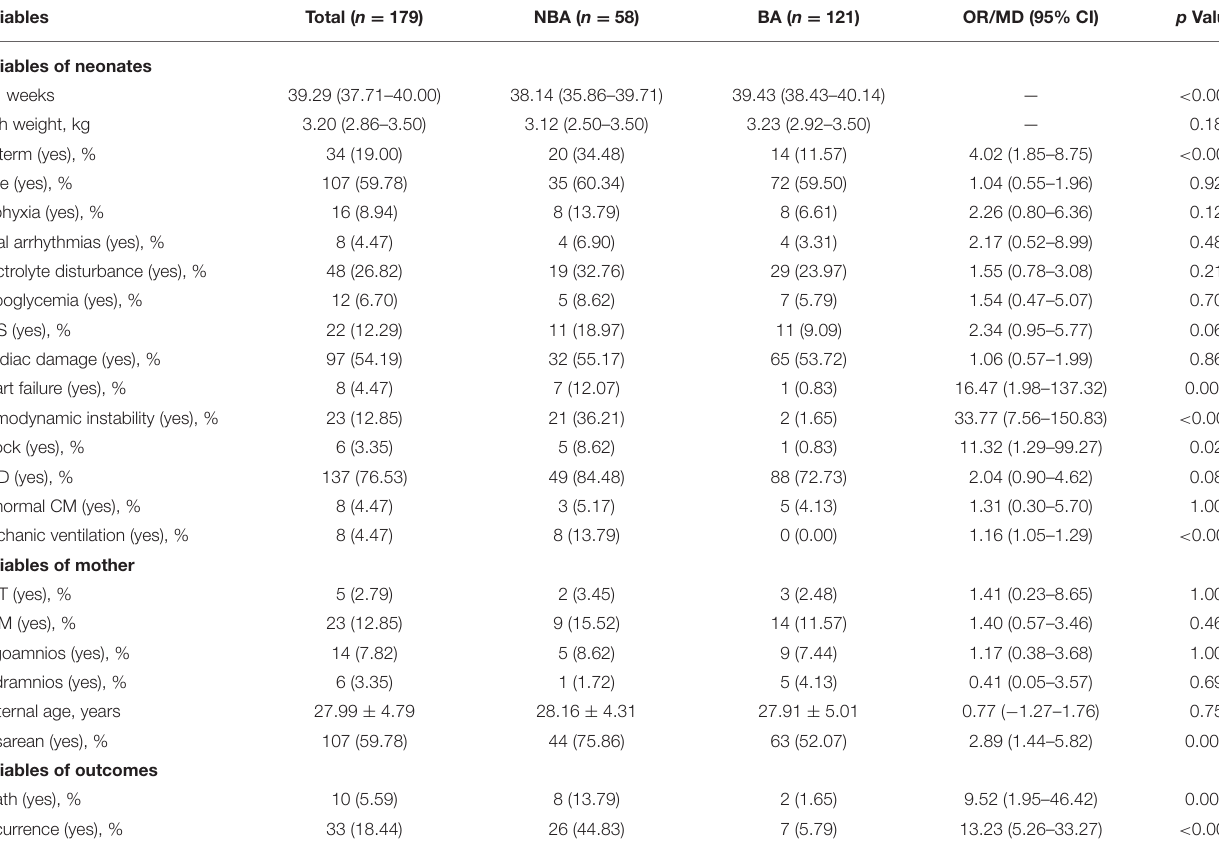
TABLE 1 | The baseline characteristics of neonates with arrhythmia.